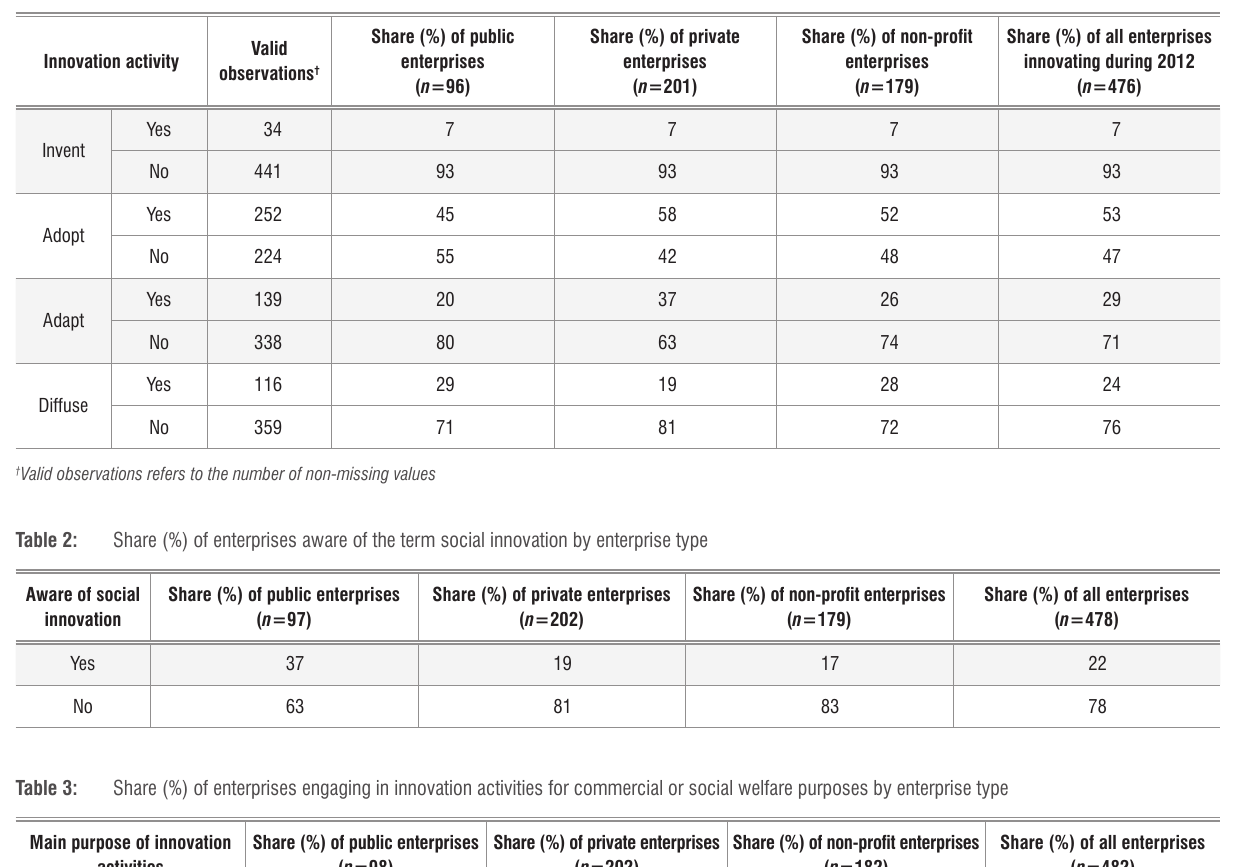
Share (%) of enterprises engaged in innovation activities by enterprise type during 2012